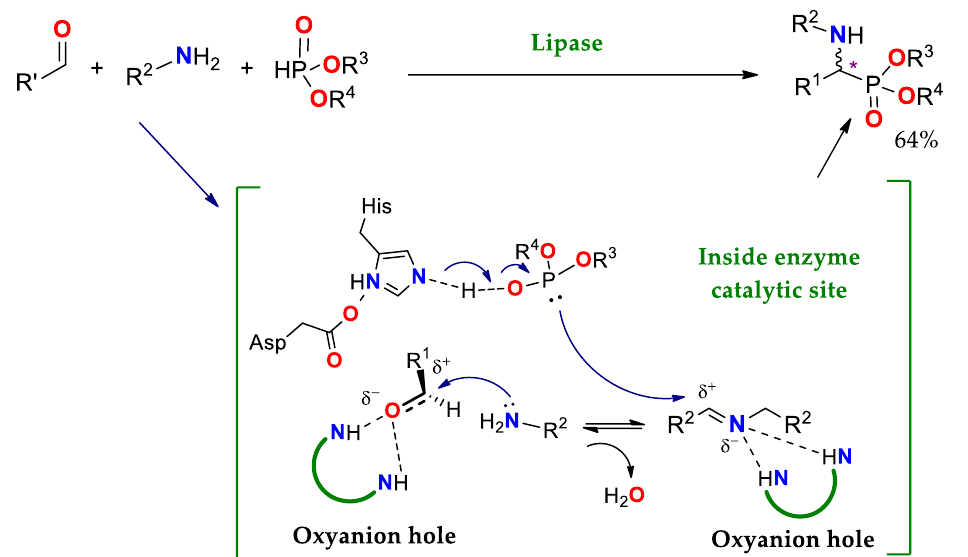
Scheme 18. Proposed mechanism of the Kabachnik – Fields reaction using lipases. Adapted from